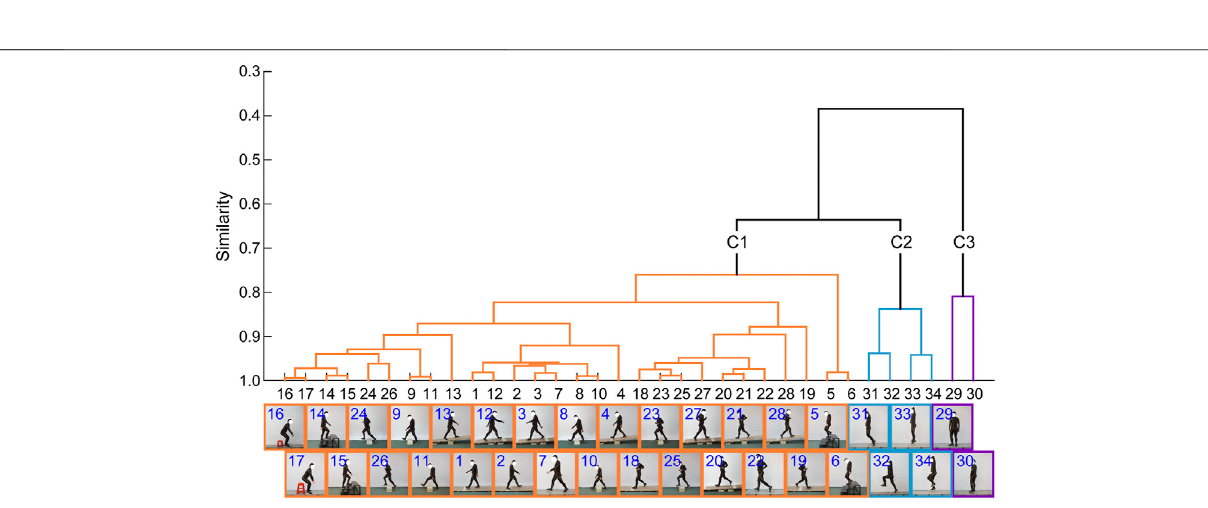
Frontiers in Bioengineering and Biotechnology |